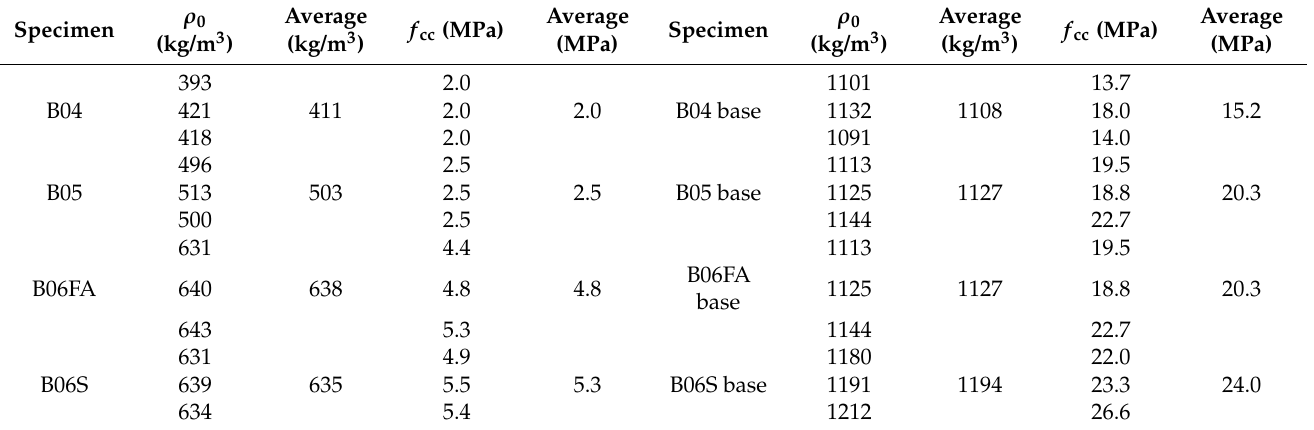
Table 8. Test result of cubic compressive strength of AAC and base material.